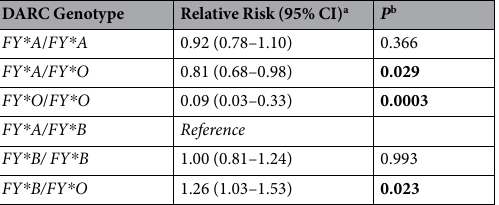
Table 2. Effect of the DARC genotypes on the risk of clinical P. vivax malaria. a The relative risk of clinical